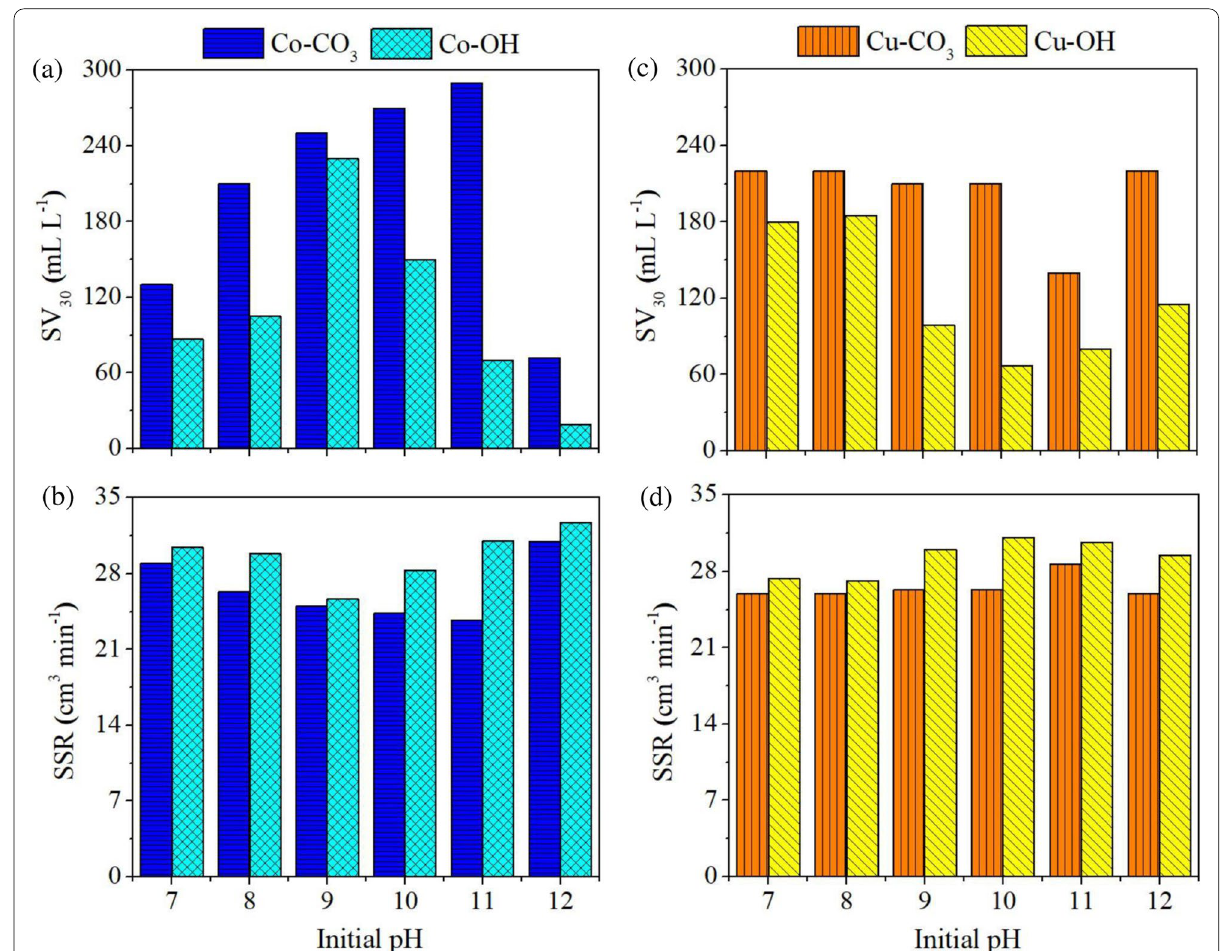
Fig. 5 Sludge volume at 30 min and sludge settling rate at different pH values for cobalt ( a , b ) and copper ( c , d ) using different